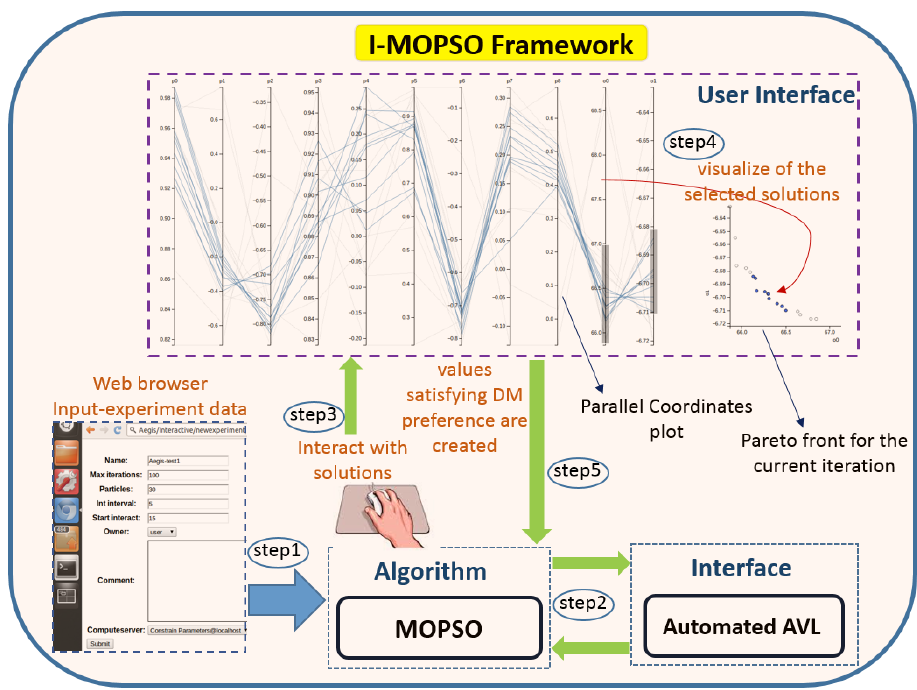
Figure 2. Interactive optimisation approach methodology incorporates decision maker preference within the optimisation